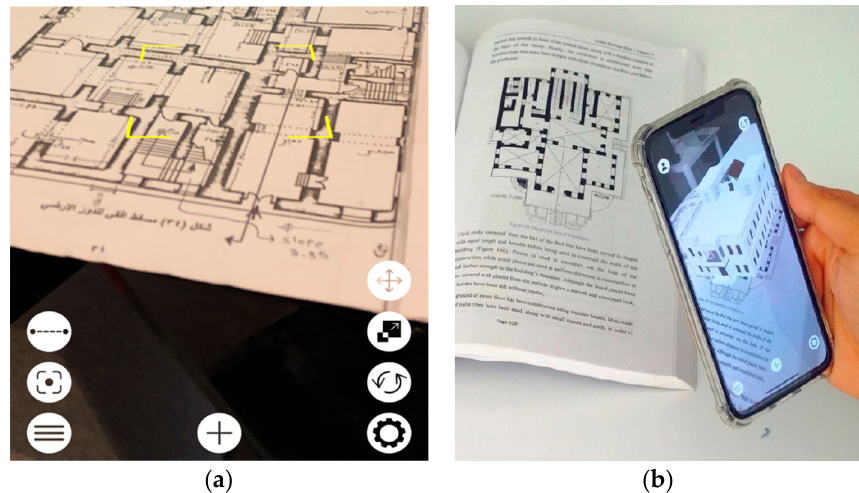
Figure 15. ( a ) Scanning the marker and ( b ), visualizing the model in AR Environment.